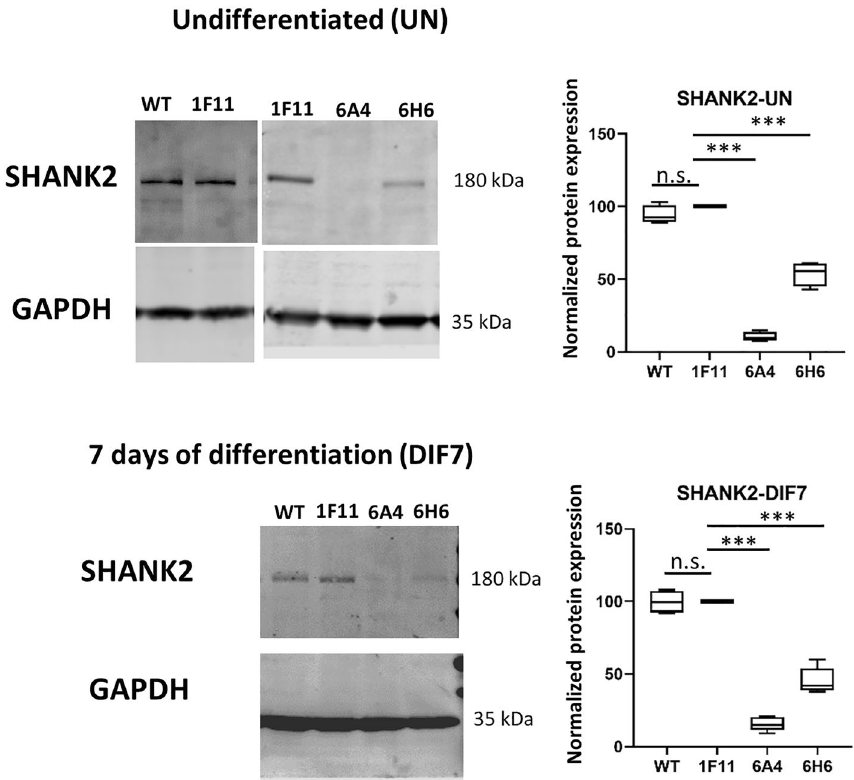
Figure 1. Western blot analysis of SHANK2 expression in genome-edited cell lines (6A4, 6H6) versus the non- edited controls (1F11, WT). SHANK2-expression was normalized against the expression of GAPDH (reference) in undifferentiated cells (UN) and in cells after 7 days of neuronal differentiation (DIF7). Cropped western blot membrane images are shown and full-length blots are presented in Supplementary Fig. 2. n = 4 experiments. One-way ANOVA was performed and the two different mutant cell lines as well as the WT control were compared to the control 1F11 (ANOVA results: SHANK2-UN F = 266.8, P < 0.0001; SHANK2-DIF7 F = 229.8, P < 0.0001). Correction for multiple testing with Dunnett’s test (n = 3 tests for each time point). Data were presented as box-plots and the corrected P-values are indicated. ***P ≤